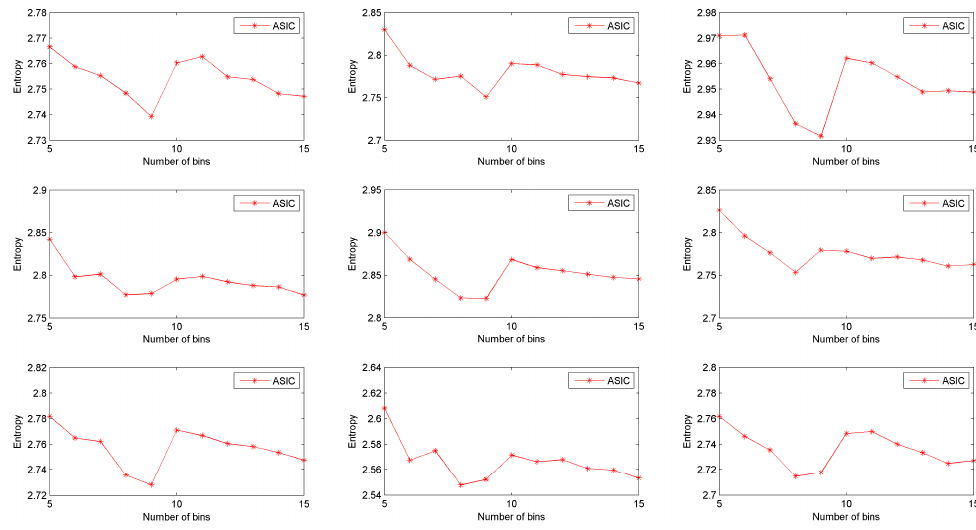
Figure 6. Effects of number of bins.